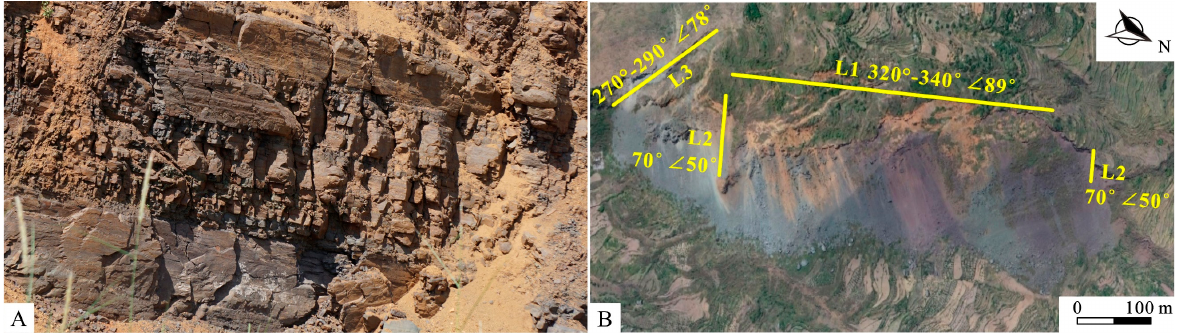
Figure 7. Typical geological phenomena controlled by the structural planes: ( A ) the blocky rock mass; and ( B ) landslide boundary controlled by structural planes (taken by UAV).